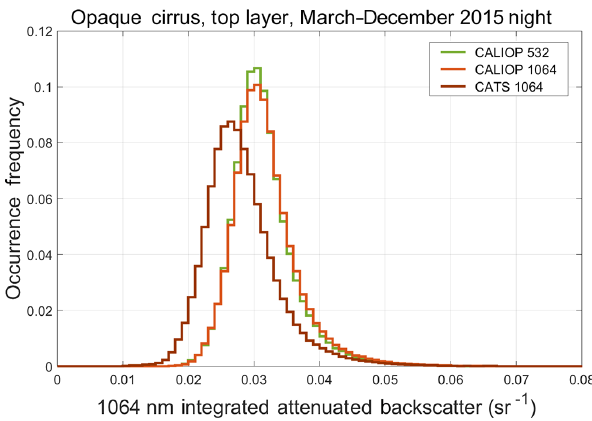
Figure 11. Relative frequency distributions of March–December 2015 nighttime integrated attenuated backscatter for opaque cirrus clouds measured by CALIOP at 532 and 1064nm and by CATS at 1064nm only.